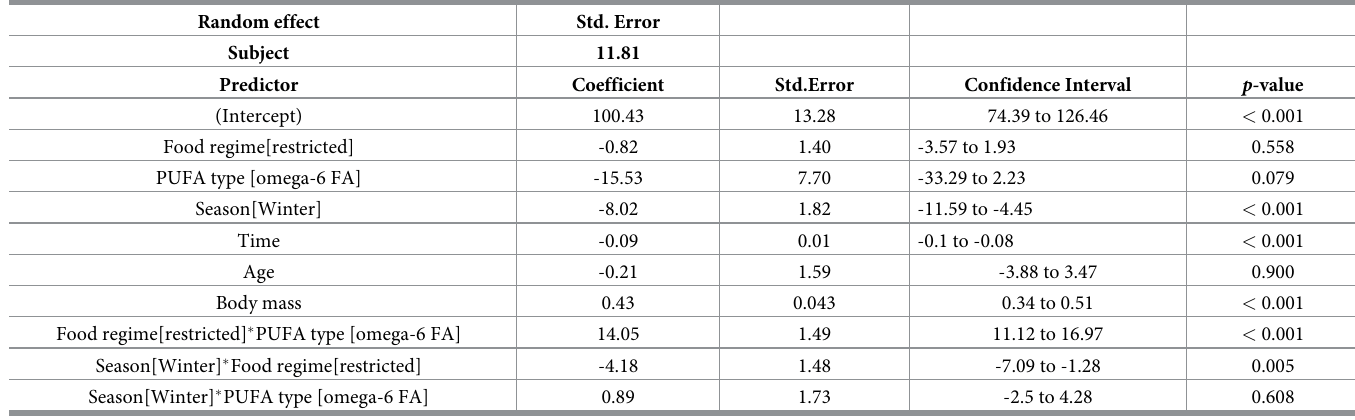
Table 2. Factors explaining the variation in direct systolic arterial pressure of anaesthetised female red deer. Results of the best fitted linear mixed effect model explaining systolic arterial blood pressure of female red deer ( Cervus elaphus , n = 11) during anaesthesia with 0.1 mg/kg medetomidine and 3 mg/kg tiletamine-zolazepam. Animals were anaesthetised twice in winter ( ad libitum and restricted feed) and twice in summer ( ad libitum and restricted feed) and received pellets enriched with omega-3 FA (n = 5) or omega-6 FA (n = 6) (type of PUFA supplementation). Random effect